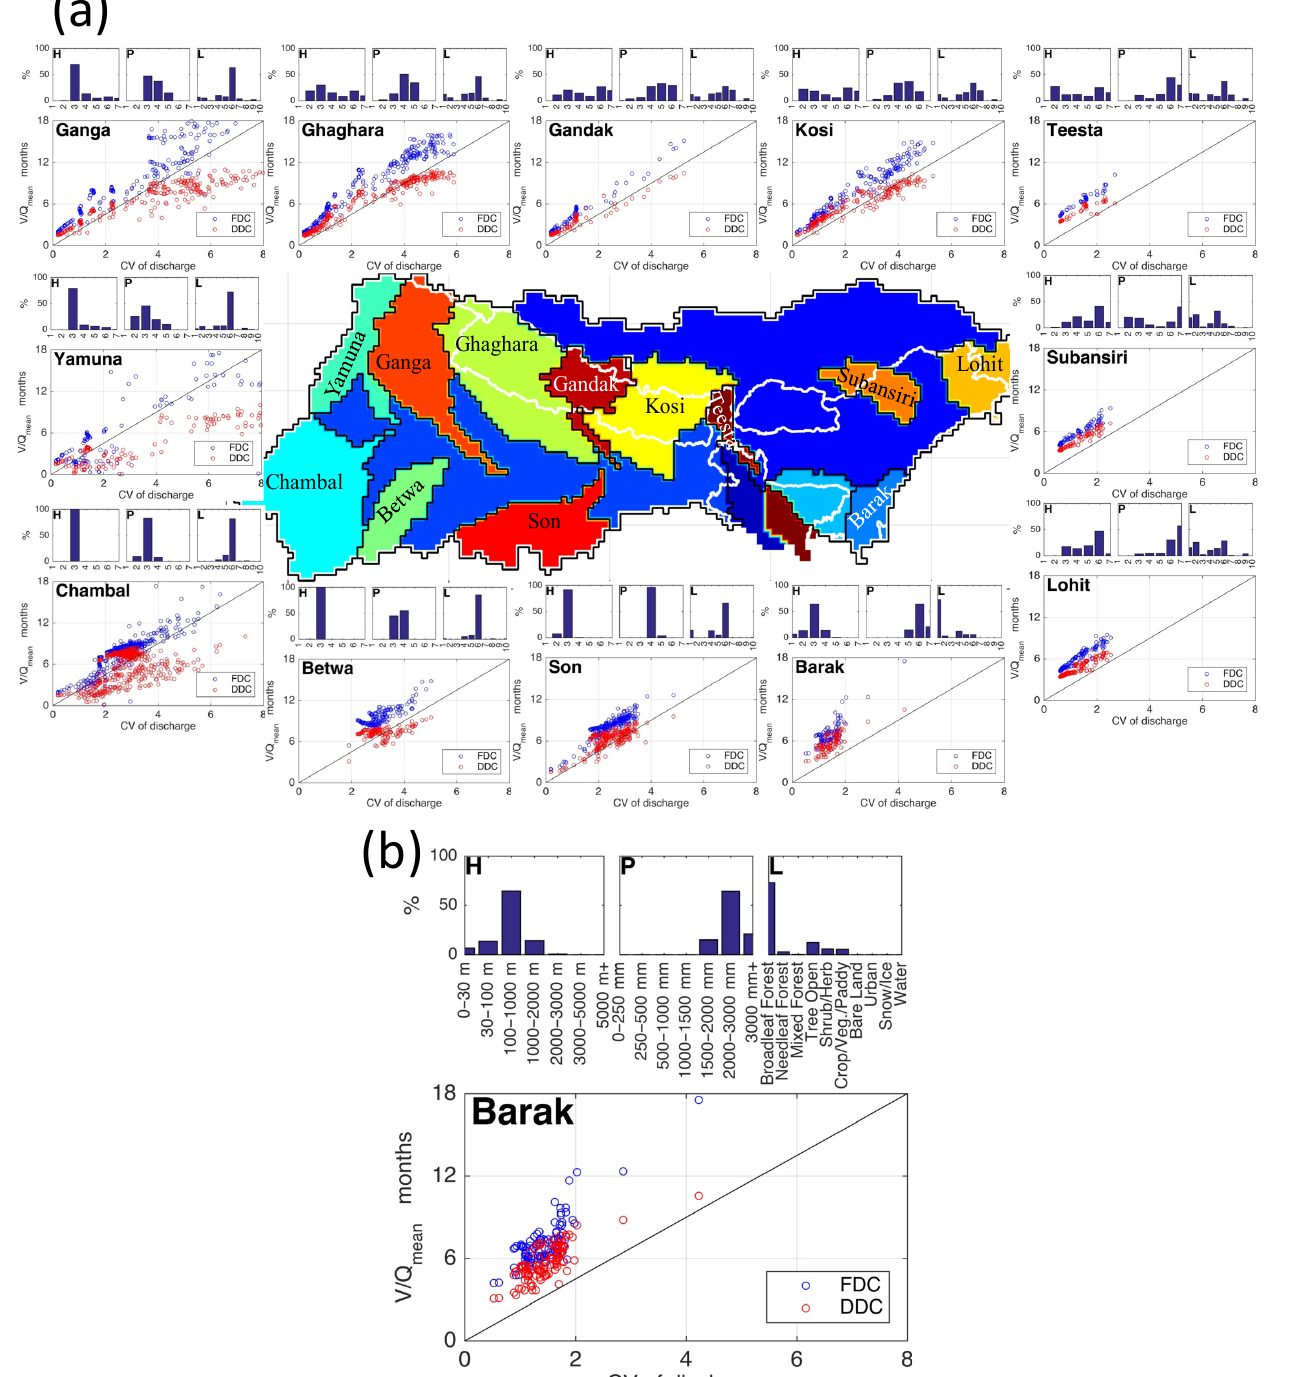
Figure 17. (a) Zoom-ups of Fig. 15 at the selected 12 sub-basins of the GBM with a summary of elevation ( H ), precipitation ( P ) and land cover ( L ) distribution, i.e., the relation between necessary storage in months and CV of daily discharge for flood (blue) and drought (red) management at all grid points of sub-basins as indicated in the center with maintaining discharge Q T = Q mean during a 5-year return period. The simulated discharge was for 1980–2001. (b) Legend of diagrams in (a)